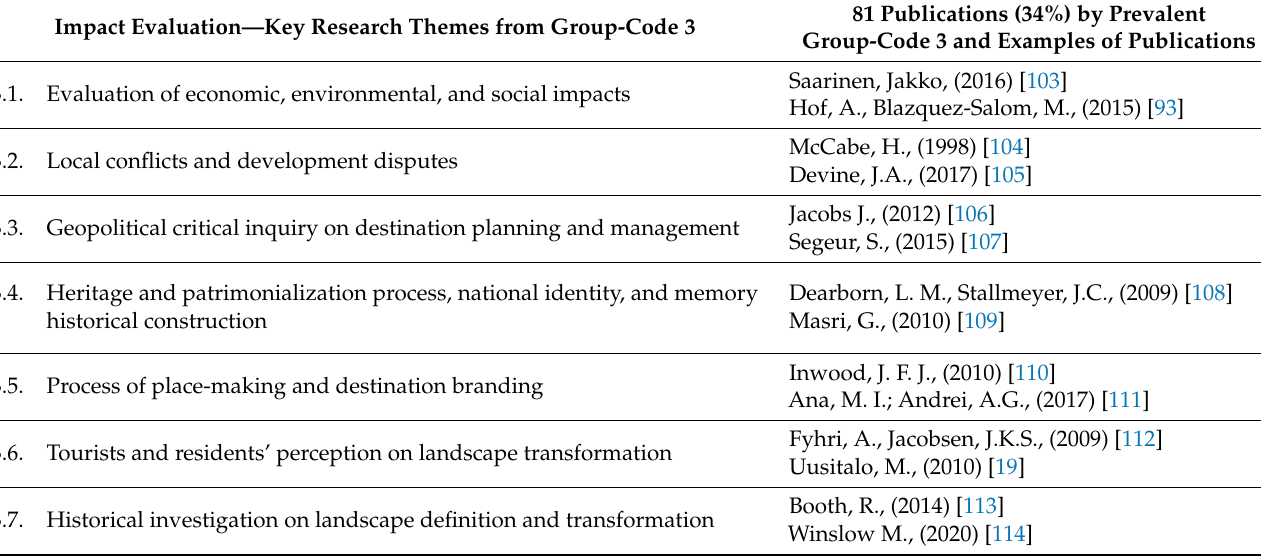
Table 5. Group-code 3—Number of articles by prevalent key theme and examples of publications. Impact Evaluation—Key Research Themes from Group-Code 3